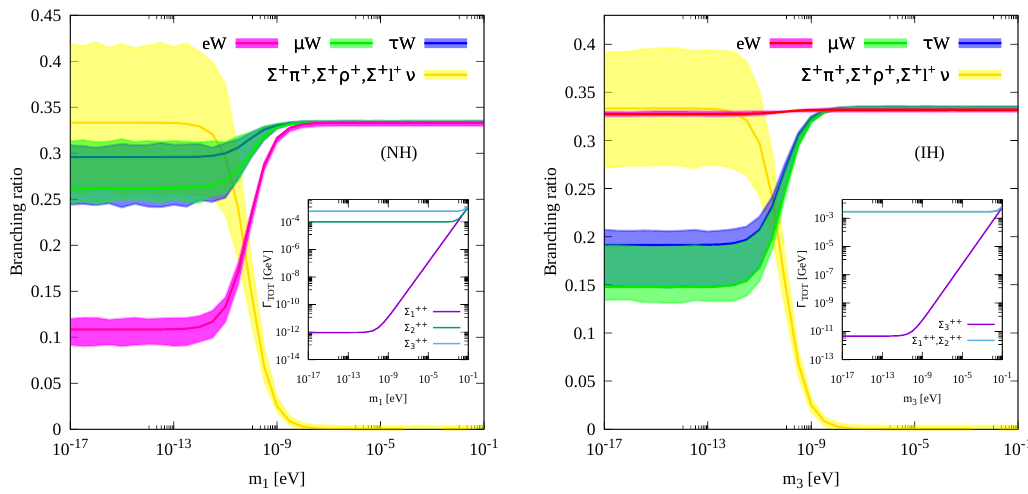
Figure 6 . Average branching ratios for the decay modes of Σ ++ ’s as a function of m 1 ( m 3 ) for NH(IH). The total decay width ( Γ in the inset. See text for